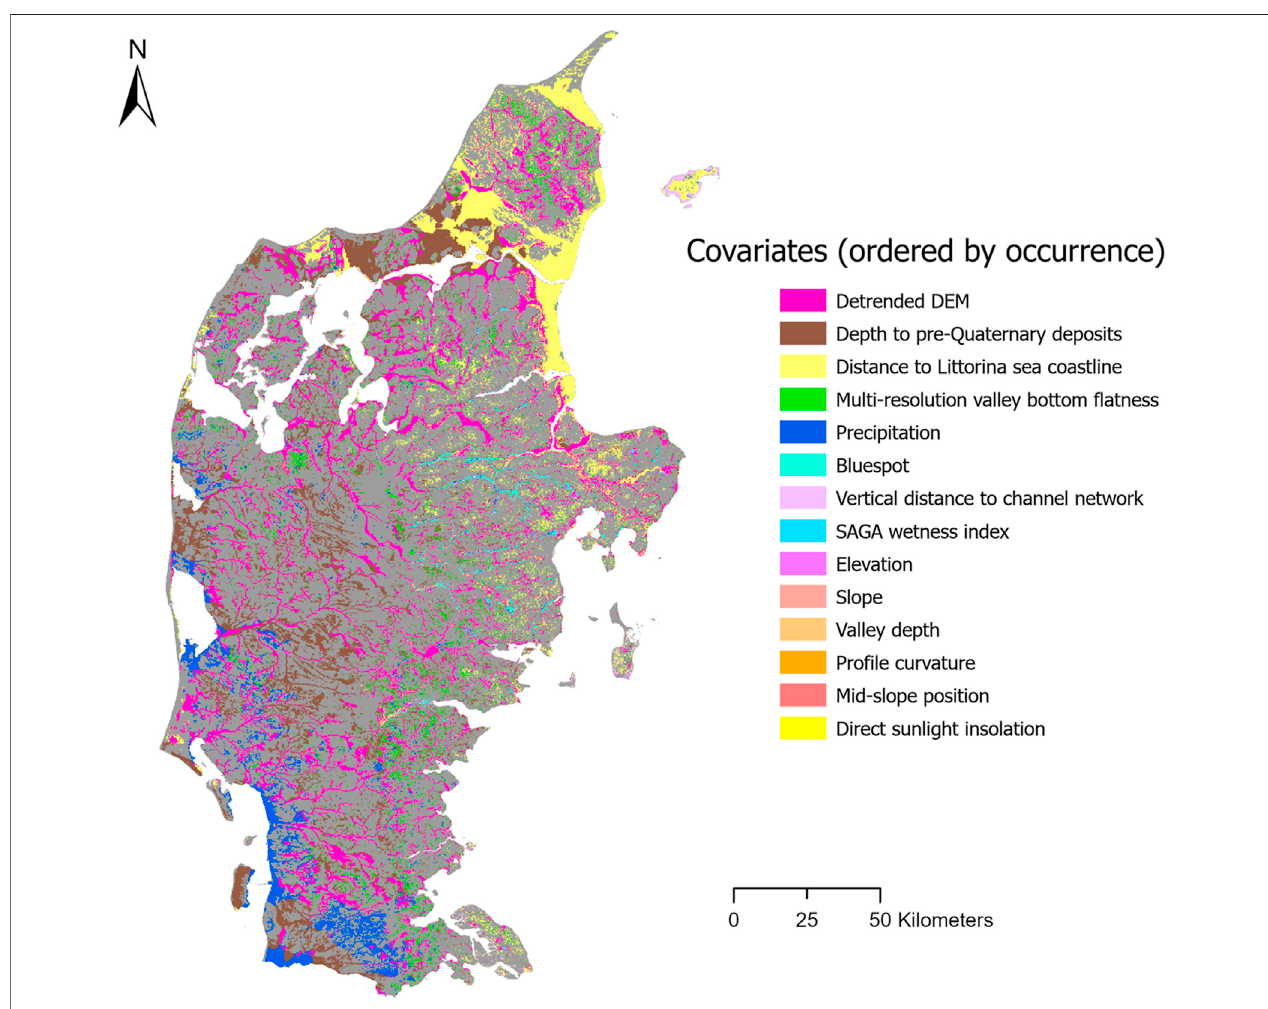
FIGURE 5 | Spatial distribution of covariates with the largest SHAP importance for each patch.